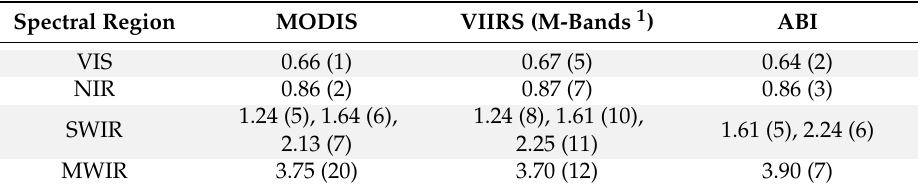
Nominal central wavelength of common spectral channels used in satellite imager optical and microphysical remote sensing algorithms for liquid water clouds, and their instrument number designation (in parentheses), for Moderate Resolution Imaging Spectroradiometer (MODIS), Visible Infrared Imaging Radiometer suite (VIIRS) and Advanced Baseline Imager (ABI). The shortwave infrared (SWIR) and midwave infrared (MWIR) channels have substantial droplet absorption with single scattering albedo (SSA) appreciably less than